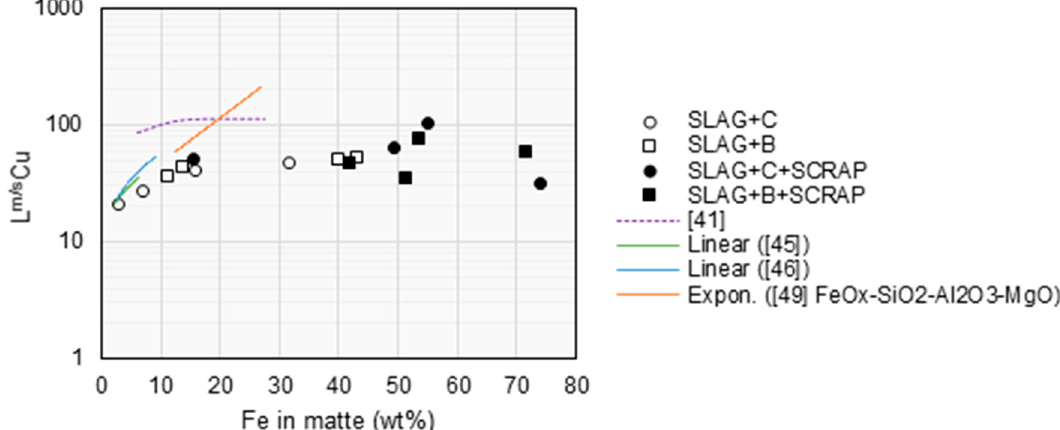
Figure 8. The distribution coefficient of copper between matte and slag as a function of matte grade at 1400 °C. Multiple other equilibrium studies [45,46,49] and kinetic study by Ruismäki et al. [41] were added in the figure.